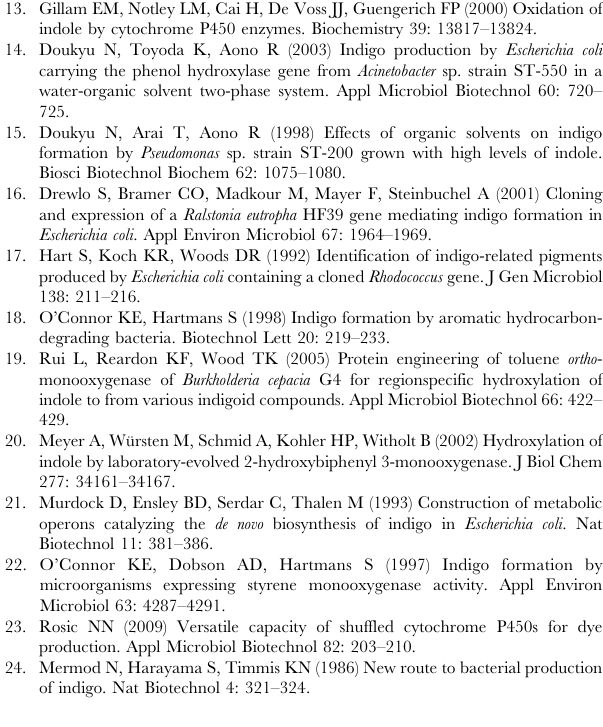
Table S3 Oligonucleotide primers used in this study. Table S4 Primers used for site-directed